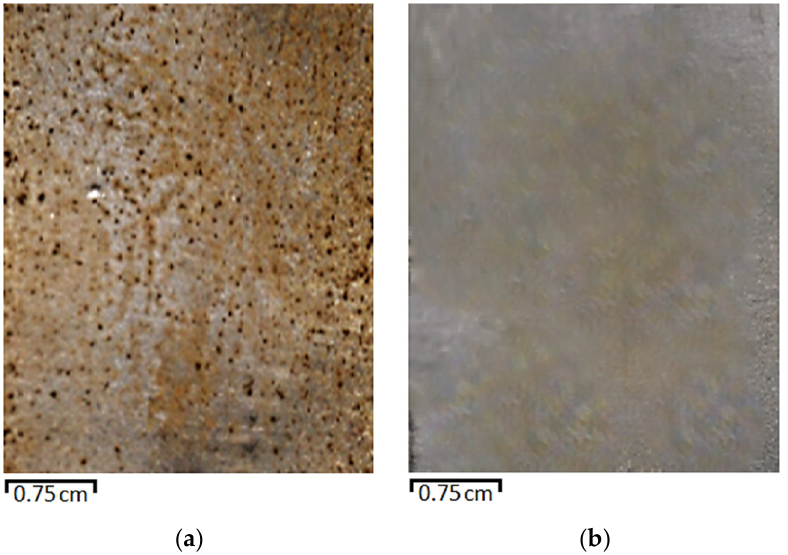
Figure 11. Appearance of the surface of steel samples subjected to corrosion tests under various conditions: ( a ) anodic polarization for 10 min at i = 20 mkA/cm 2 in 3% NaCl solution + 0.01 M (VS + BTA); ( b ) anodic polarization in ID 0.01 M (VS + BTA) for 10 min at i = 20 mkA/cm 2 in 3% NaCl solution + 1% Strodex.